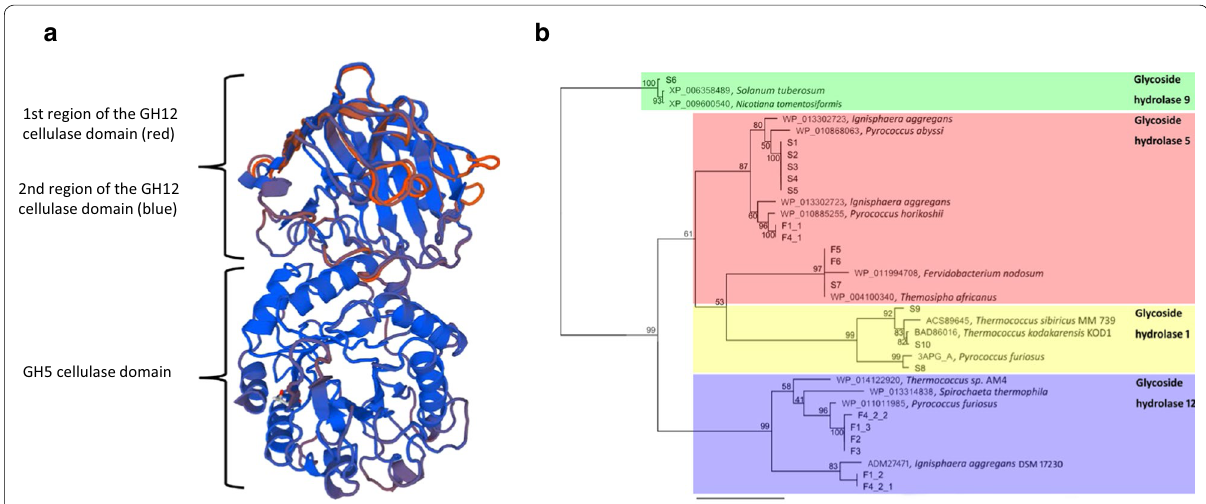
Fig. 4 a 3D model of the cellulase F1 as predicted using the Swiss-Model server. The GH5-related cellulase module F1_1, residues 44 to 412, was modeled using 3axx.1.A (87.3% amino acid identity) as the template. The GH12-related cellulase modules were modeled using 3vgi.1.A. The first GH12-affiliated module (F1_2; residues 539 to 747, 35.8% amino acid identity) is depicted in red and the second GH12-affiliated module (F1_3; residues 830–1089, 82.7% amino acid identity) is depicted in blue. b Maximum likelihood phylogenetic analysis using amino acid sequences of cel- lulases identified in this study (in bold) and previously described cellulases derived from members of the domains Eukaryota , Archaea and Bacteria . 1000 iterations were conducted for bootstrap support, and bootstrap values are indicated at each node. Cellulases affiliated with GH9 are high- lighted in green, GH12-affiliated sequences are highlighted in blue, GH5-affiliated sequences are highlighted in red and GH1-affiliated sequences are highlighted in